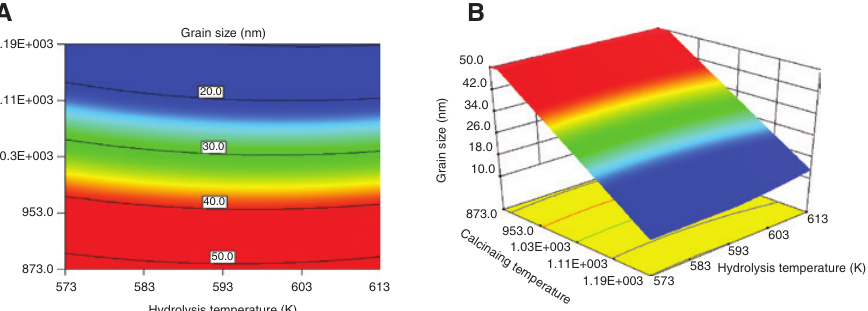
nanocrystallites. (A) Contour line map, (B) response 2